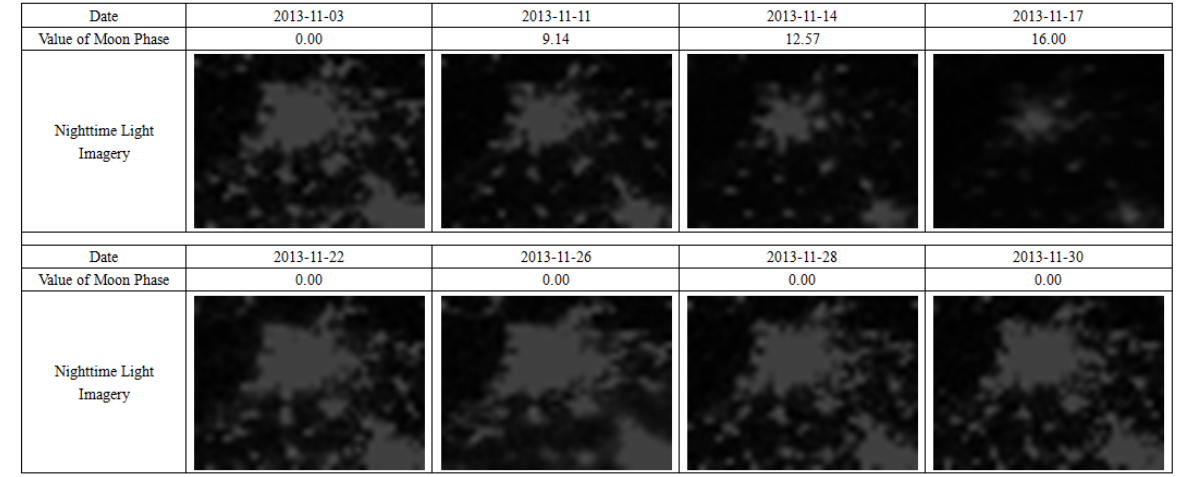
Figure 2. Relationship between the value of the moon phase and the nighttime light